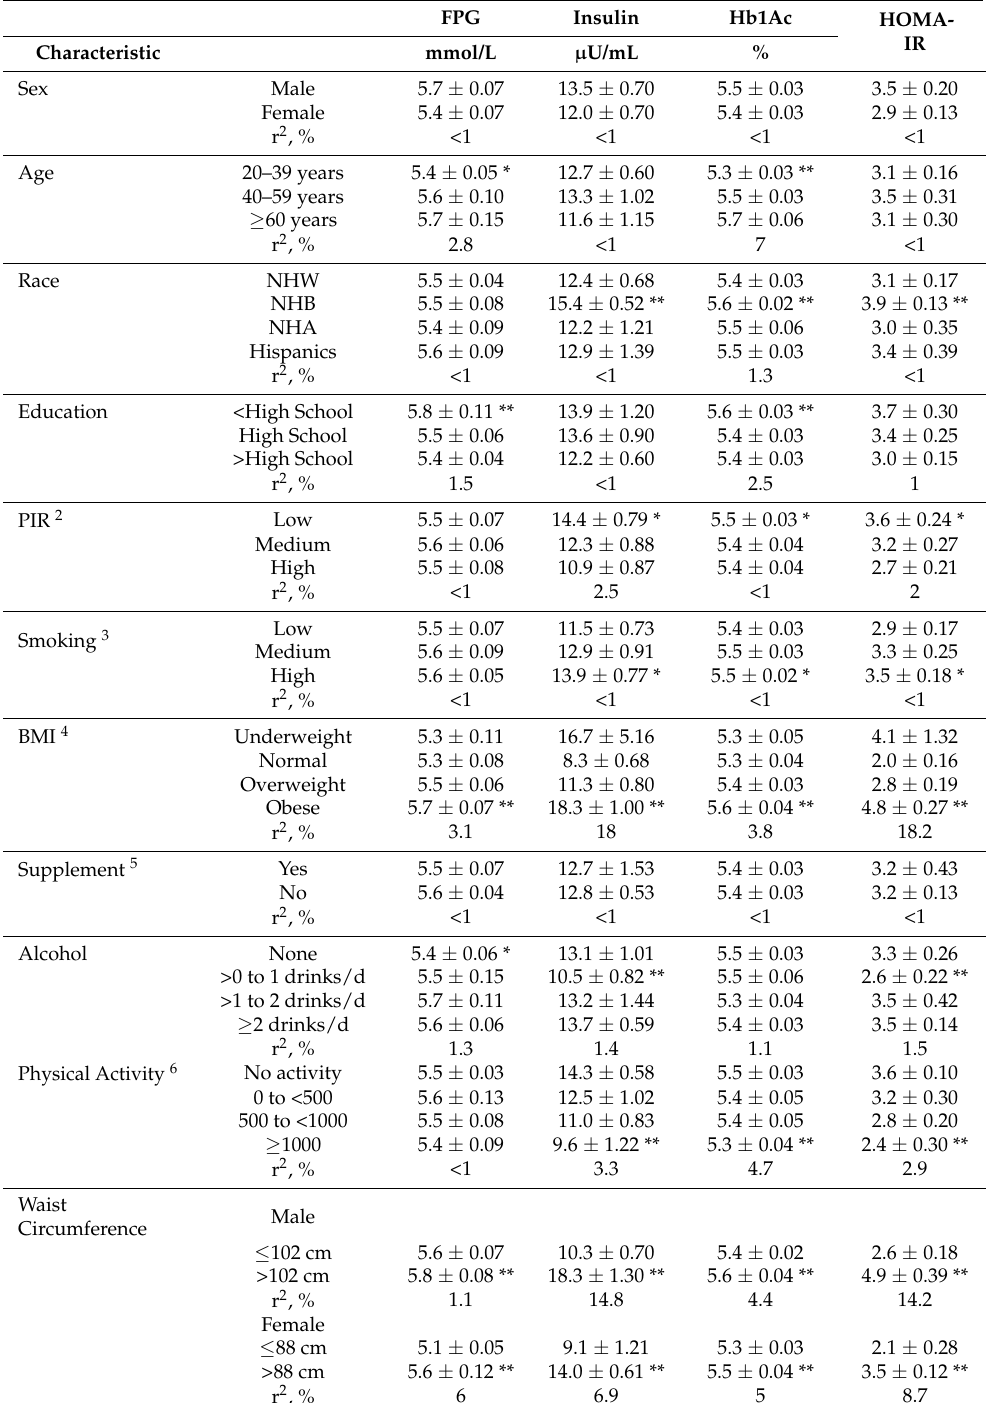
Table 3. Unadjusted insulin resistance/glucose metabolism biomarkers by covariates categories for US adults, NHANES 2011–2012 1